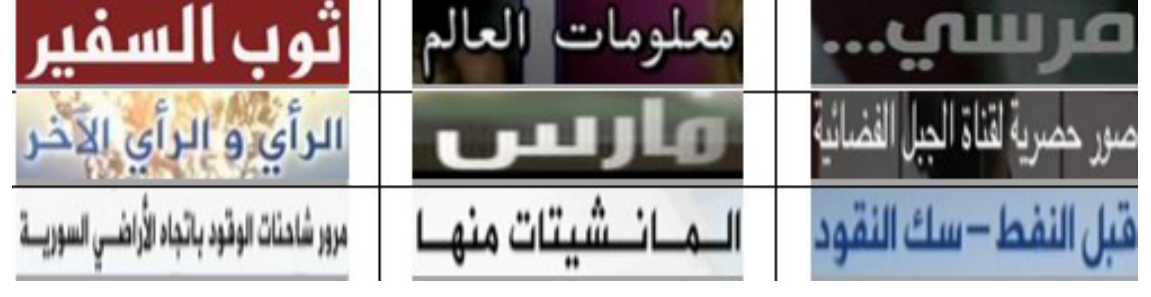
Fig. 6. ALIF dataset samples